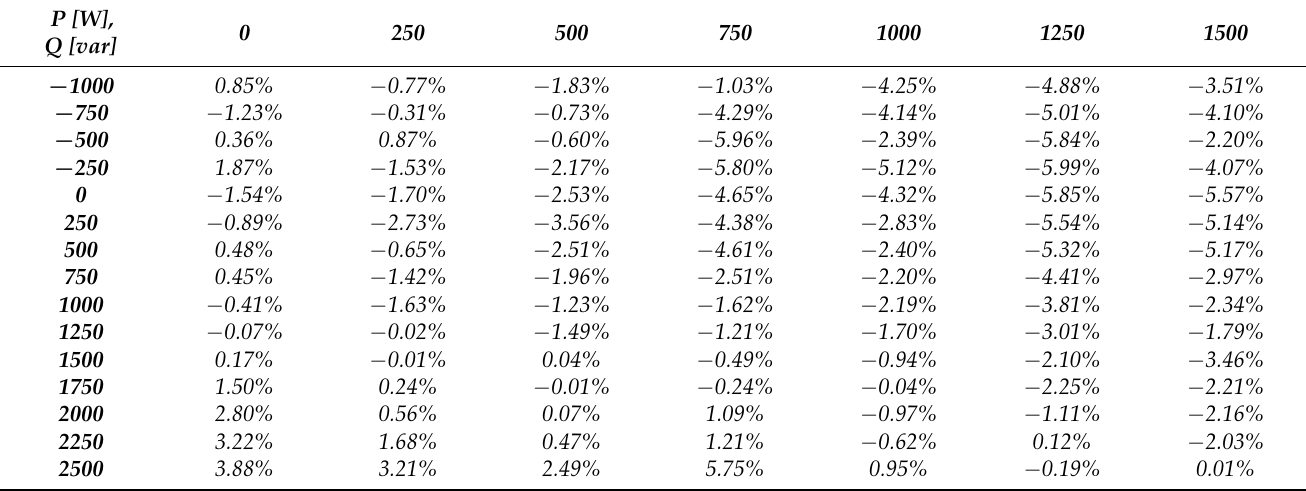
Table 4. Experimental results. Healthy theoretical model relative errors (%) with respect to the actual measurements collected from healthy condition tests, for different [P,Q] operating points at rated output voltage ( U = 400 V ).